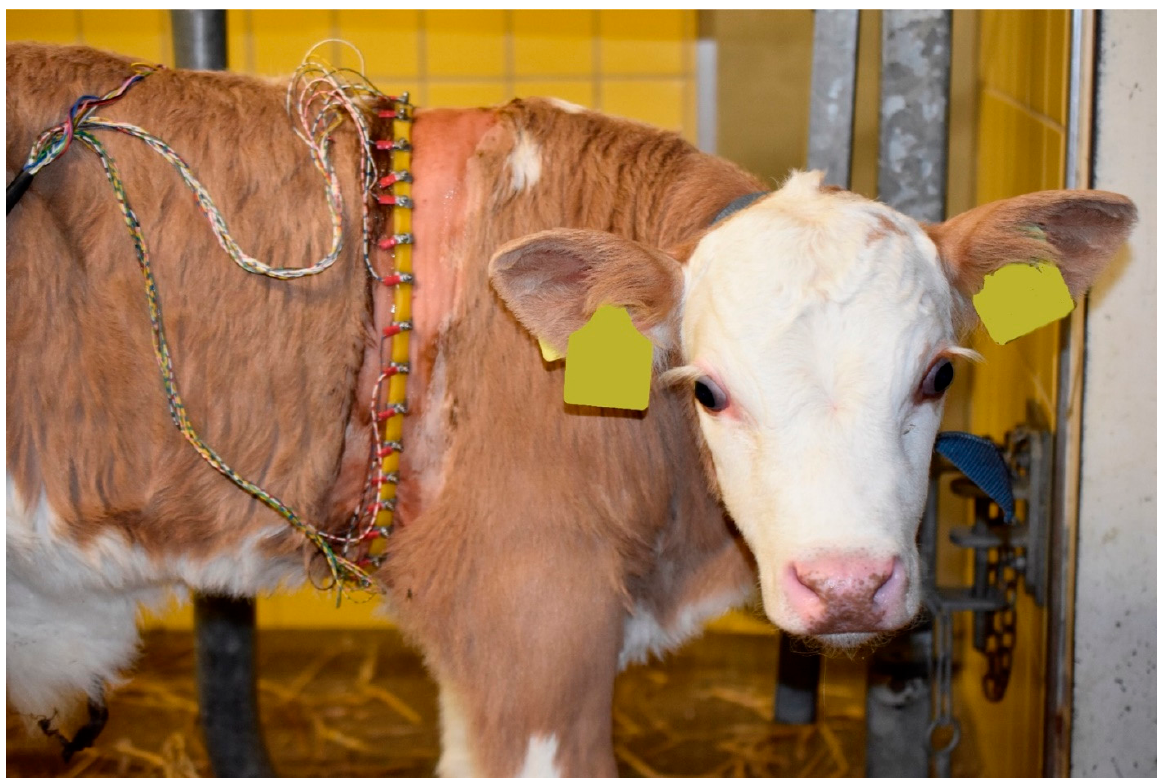
Figure 1. One week old calf with a rubber belt with 32 evenly distributed electrodes for electrical impedance tomography. The belt is placed at the level of the sixth intercostal space.